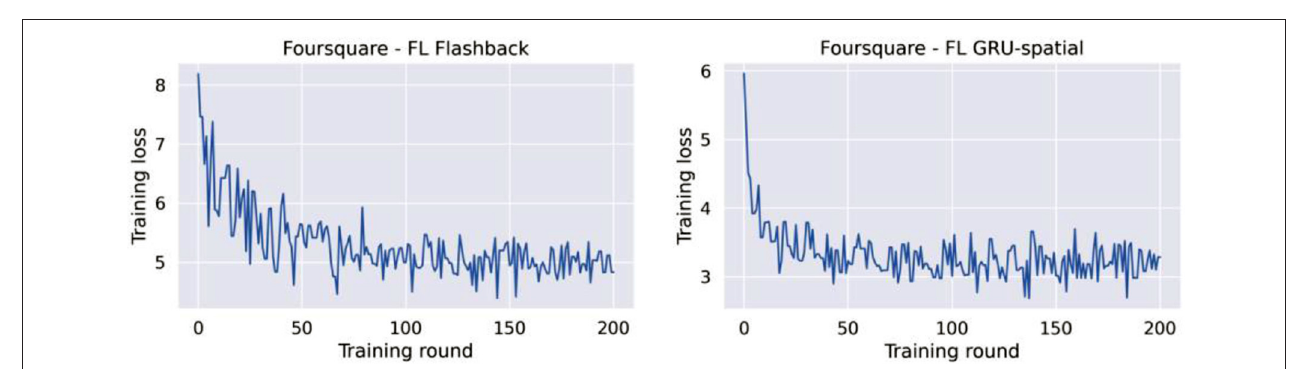
FIGURE 8 | Training loss for FL-flashback and FL-GRU with 4 clients and 200 training rounds.